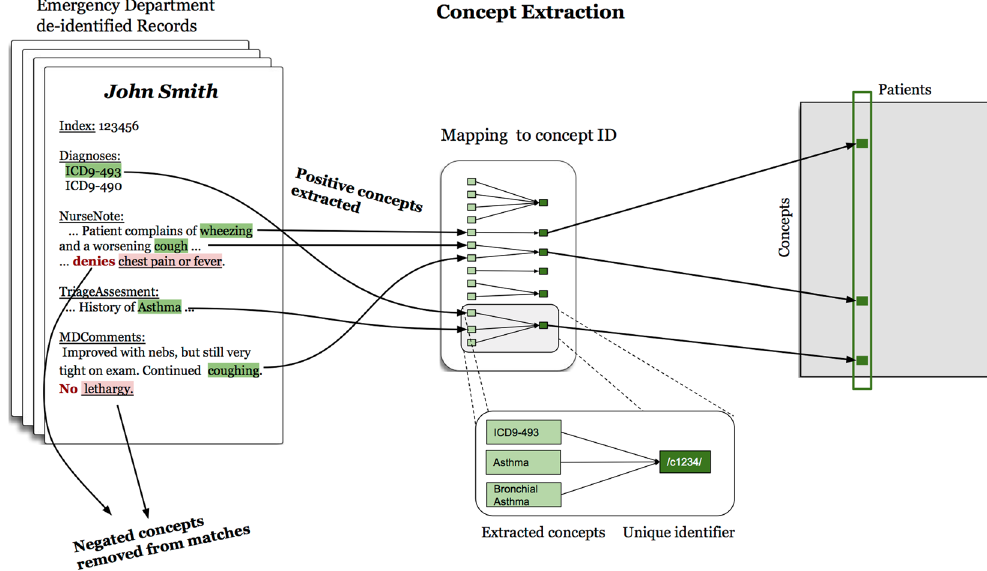
Figure 1. Concept extraction pipeline. Non-negated concepts and ICD-9 diagnosis codes are extracted from Emergency Department electronic medical records. Concepts, codes and concept aliases are mapped to unique IDs, which in turn populate a co-occurrence matrix of size (Concepts) ×